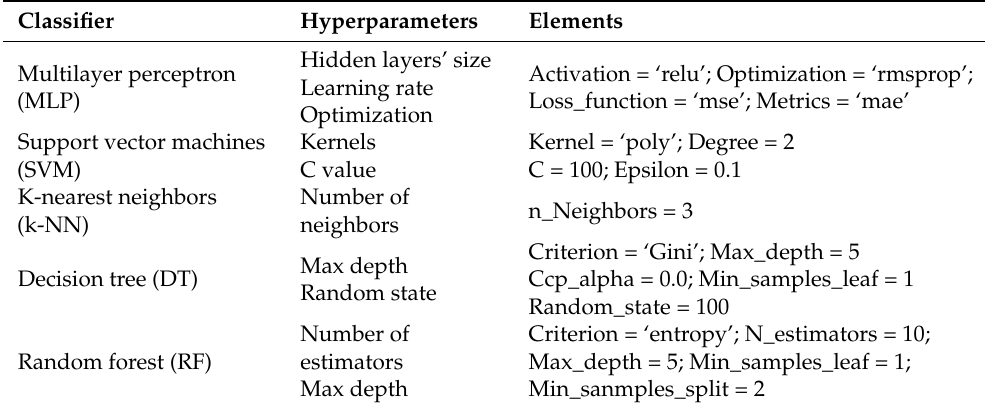
Table 2. The hyperparameters used by applied predictive